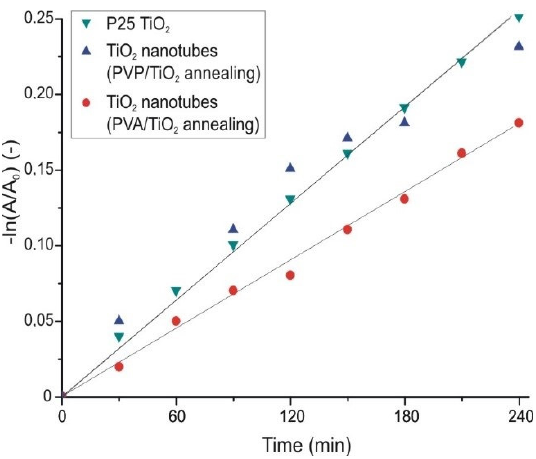
Figure 8. Kinetics of the photocatalytic reaction of the crystalline TiO 2 nanotubes.